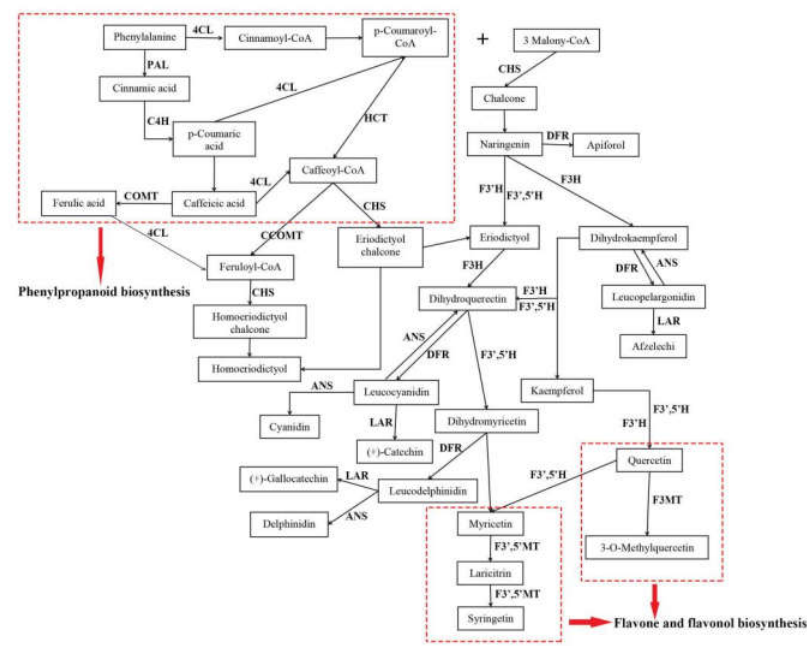
Figure 6. The flavonoid biosynthesis in A. megalophylla .